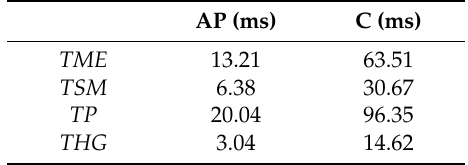
Table 3. Cryptography running time operation based on results in [8].